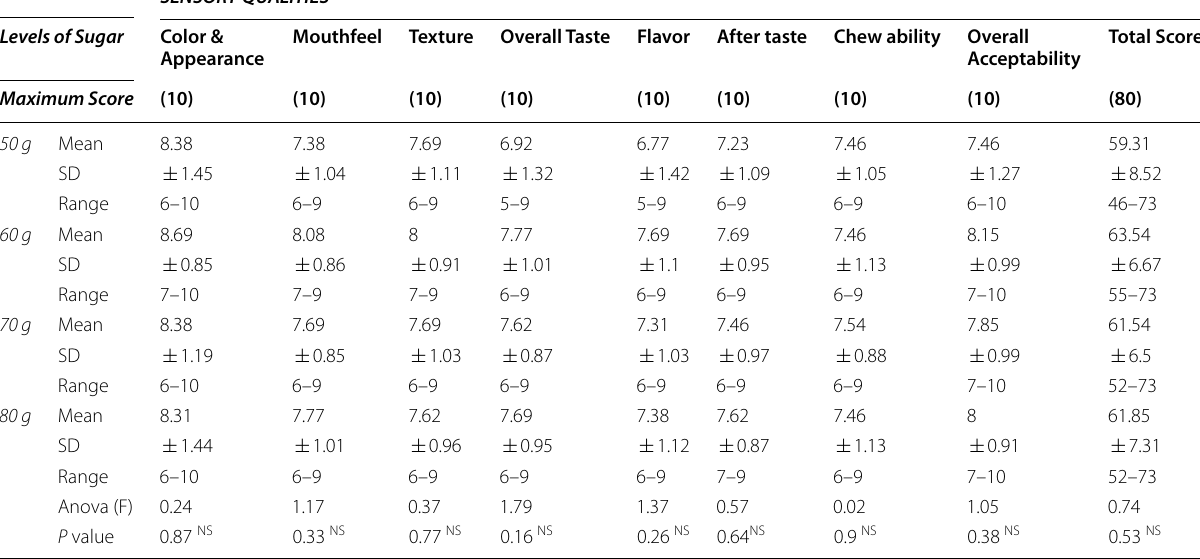
Table 2 Standardization with varying levels of sugar